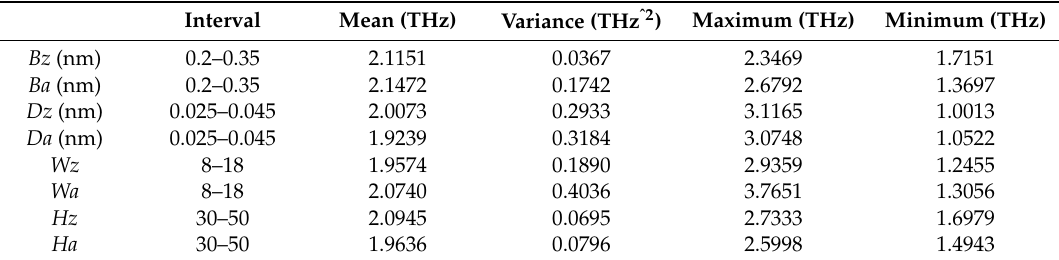
Table 3. Uncertainty analysis about parameters of geometrical properties.